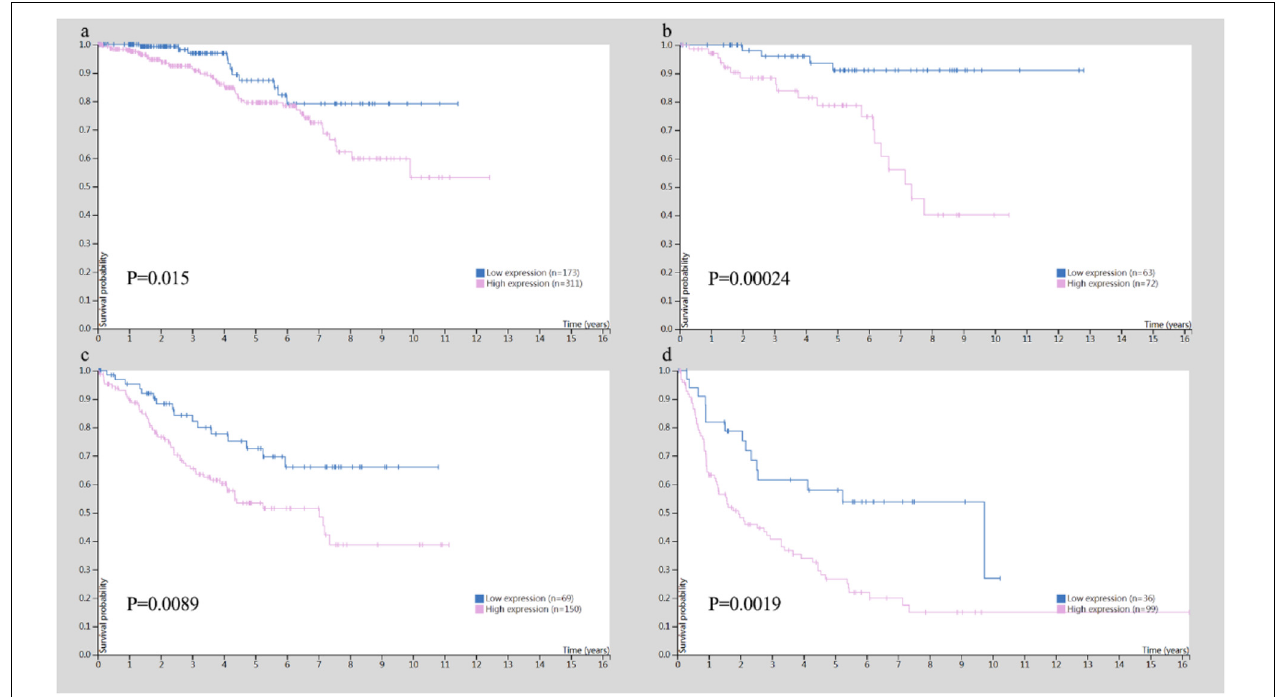
FIGURE 10 | Survival analysis for TNM stage in colon and rectal cancer. (A) Survival analysis for MYC in stage I. (B) Survival analysis for MYC in stage II. (C) Survival analysis for MYC in stage III. (D) Survival analysis for MYC in stage IV.